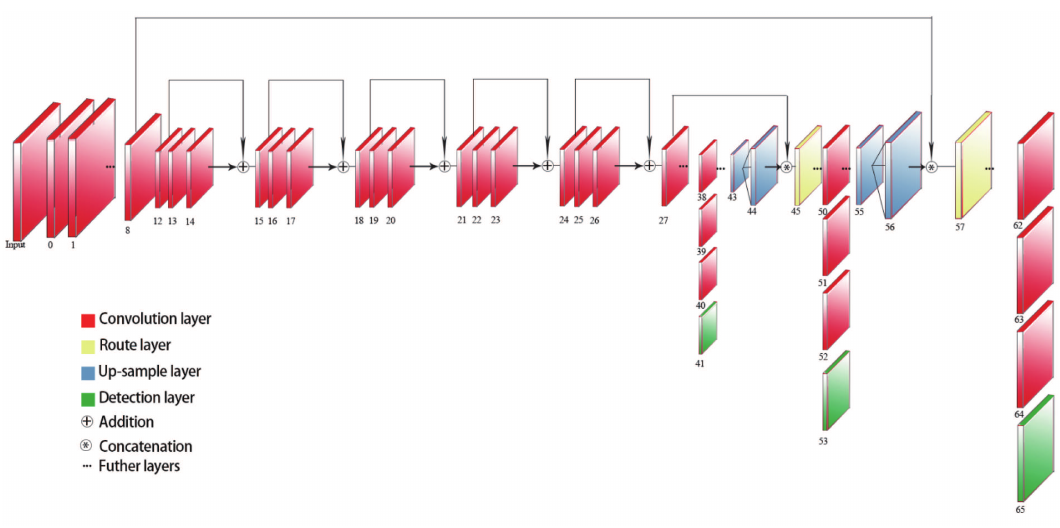
Figure 4. Network structure of the improved YOLOv3.